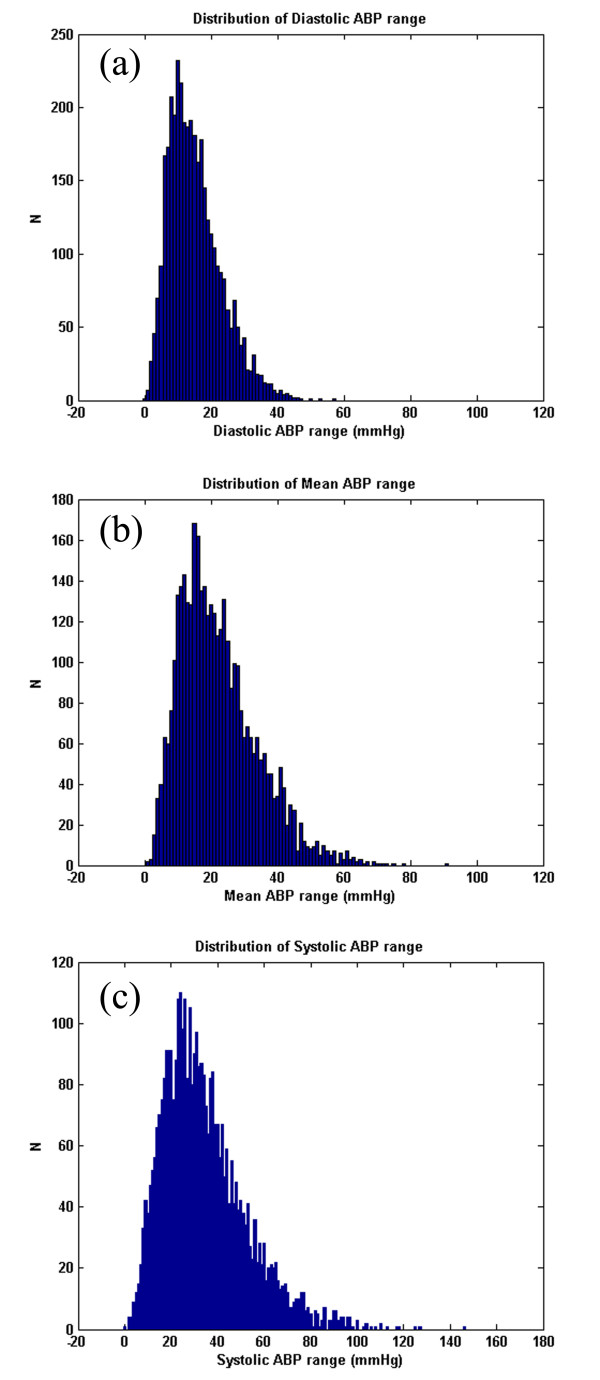
The distribution of true BP range (ABPmax-ABPmin) of the clean dataset for the DBP(a), MBP(b) and SBP(c) for each segment of data comprising 3762 data segments of 1 hour or longer continuous waveform data (1.62 ± 0.69 h).